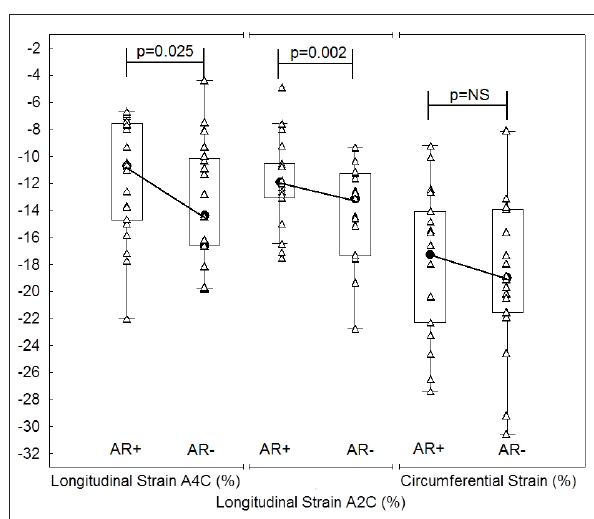
Fig. 2. Boxplots of individual strain rates with the same details as described in fig. 1.